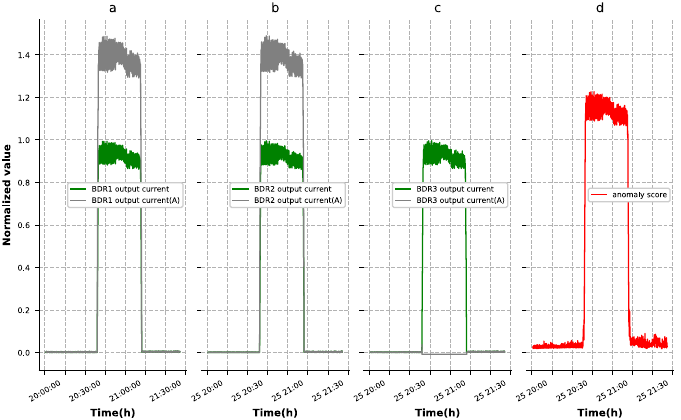
Figure 10. Detection result of the main error amplifier (MEA) circuit failure ((A) indicates the anomalous curve). ( a ) The normal BDR1 output current and anomalous BDR1 output current. ( b ) The normal BDR2 output current and anomalous BDR2 output current. ( c ) The normal BDR3 output current and anomalous BDR3 output current. ( d ) The anomaly score of the reconstruction results.